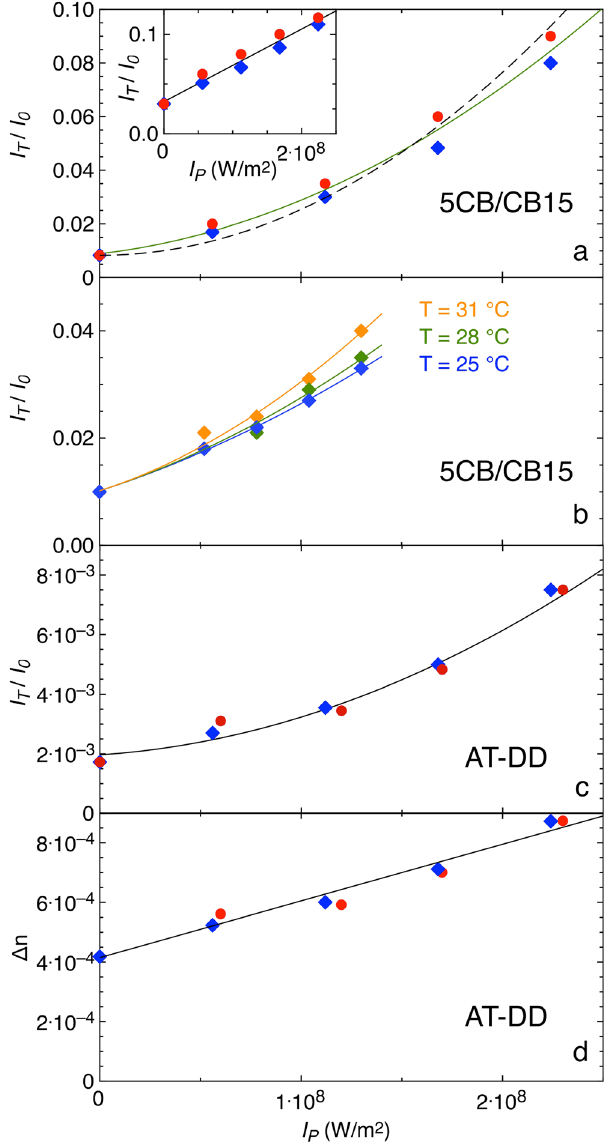
Figure 3. Optically modulated transmission and induced birefringence. ( a , b , c ) Transmitted probe beam intensity ( I T ) normalized to the incident probe intensity ( I 0 ) as a function of the pump intensity ( I P ) polarized along x (blue diamonds) and along y (red dots) measured in 5CB/CB15 at room T ( a ), in 5CB/CB15 at three different T ( b ), and in the AT-DD cell ( c ). Measurements are performed with polarizers at extinction. Dashed lines: fit to the data with Eq. 7. Continuous lines: fit to the data with Eq. 9. Inset: same measurements with analyzer rotated away from the extinction position, fitted with a linear dependence (continuous line). ( d ) Optically induced birefringence in the AT-DD N * phase extracted from the data in panel c by Eq. 1 fitted with a linear dependence